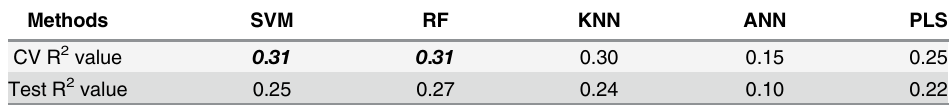
Table 8. dTm regression.